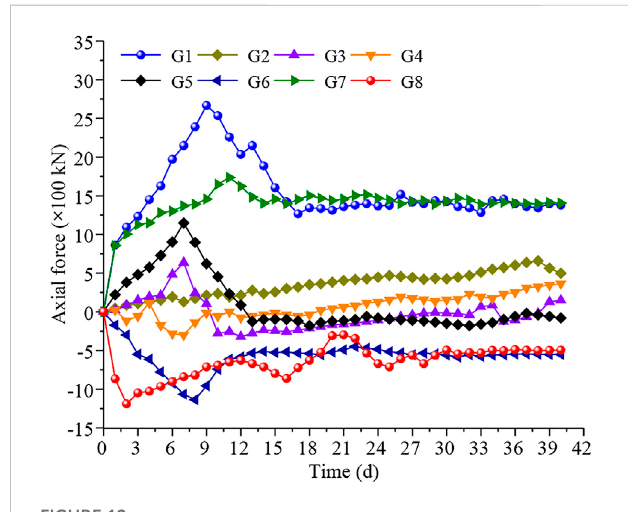
FIGURE 12 Time-history curve of axial force of steel arch frame at section